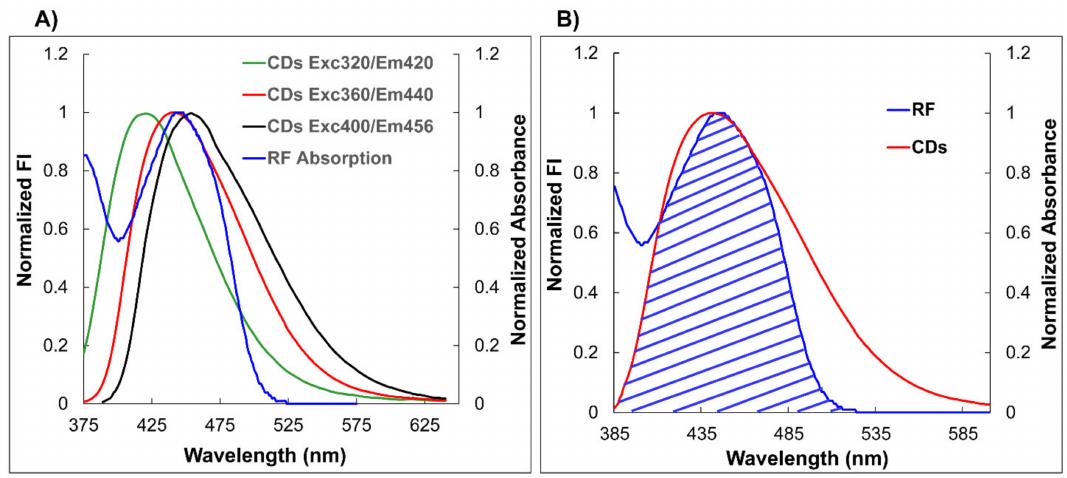
Figure 3. ( A ) UV-visible absorption spectrum of RF and emission spectra of CDs at different excitation wavelengths and ( B ) Spectral overlap between the emission spectrum of CDs (Exc 360/Em 440) and the RF absorption